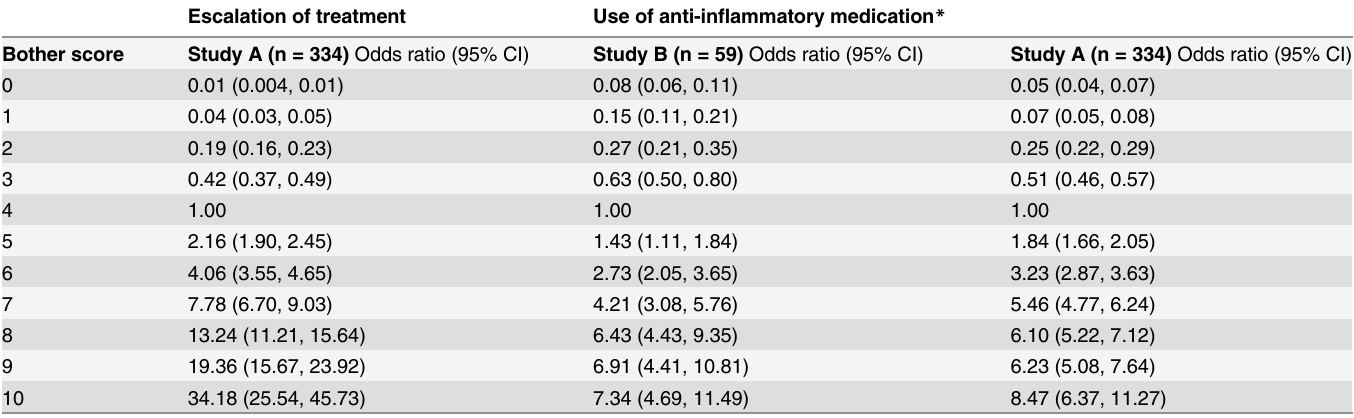
Table 3. Odds of experiencing an AE flare (escalation of treatment) and odds of using anti-inflammatory medication by self-reported bother scores each day. Escalation of treatment